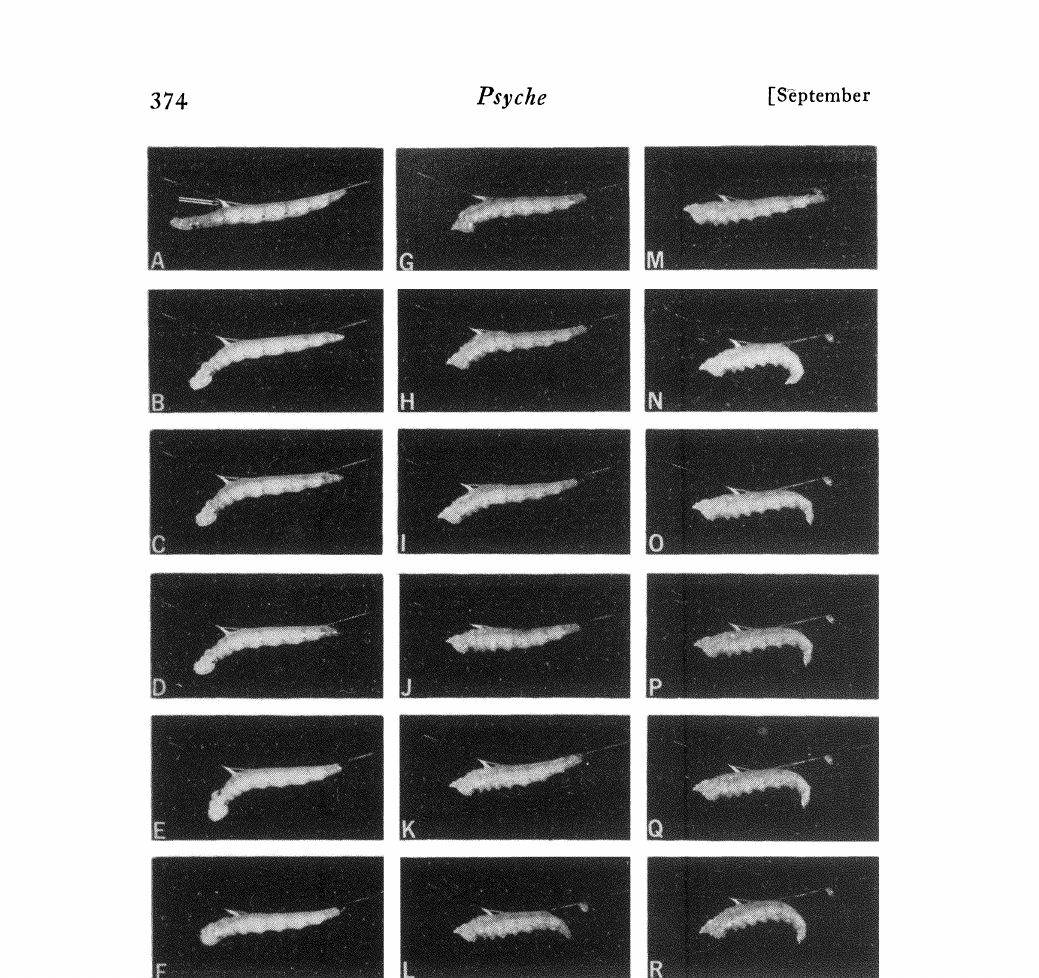
Fig. 5. Pupation. Pictures a, b, c, and d were taken 20, 2, %, and 1/ hour respectively before picture e. Strong contractions had just started when e was taken, and each subsequent picture was taken 30 seconds later. Arrow in a marks collar of silk spun by